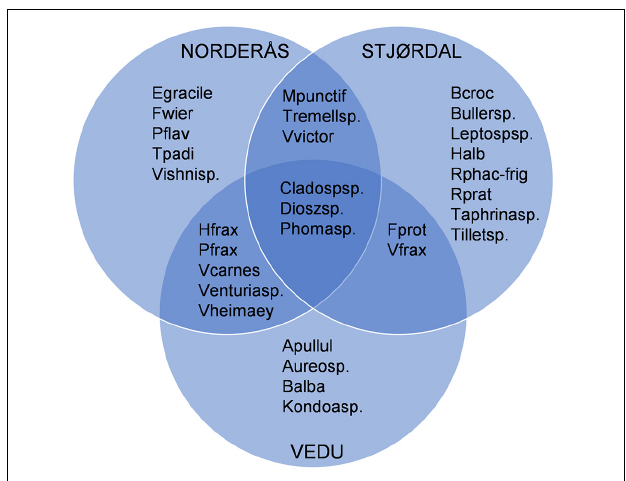
FIGURE 5 | Overview of the 20 most common OTUs that are shared or unique to each site, OTUs that were identified only as Fungi sp. were excluded from the diagram. Explanation: Apullul, Aureobasidium pullulans ; Aureosp., Aureobasidium sp.; Balba, Bullera alba ; Bcroc, Bullera crocea ; Bullersp, Bullera sp.; Cladospsp., Cladosporium sp.; Dioszsp., Dioszegia sp.; Egracile, Exobasidium gracile ; Fwier, Filobasidium wieringae ; Fprot, Fusicladium proteae ; Halb, Hymenoscyphus albidus ; Hfrax, Hymenoscyphus fraxineus ; Kondoasp., Kondoa sp.; Leptospsp., Leptosphaeriaceae sp.; Mpunctif, Mycosphaerella punctiformis ; Pflav, Papiliotrema flavescens ; Pfrax, Phyllactinia fraxini ; Phomasp., Phoma sp.; Rphac-frig, Ramularia phacae-frigidae ; Rprat, Ramularia pratensis ; Tpadi, Taphrina padi ; Taphrinasp., Taphrina sp.; Tremellsp ., Tremellomycetes sp .; Tilletsp., Tilletiopsis sp.; Vfrax, Venturia fraxini ; Venturiasp ., Venturia sp.; Vcarnes, Vishniacozyma carnescens ; Vheimaey, Vishniacozyma heimaeyensis ; Vishnisp., Vishniacozyma sp.; Vvictor, Vishniacozyma victoriae .